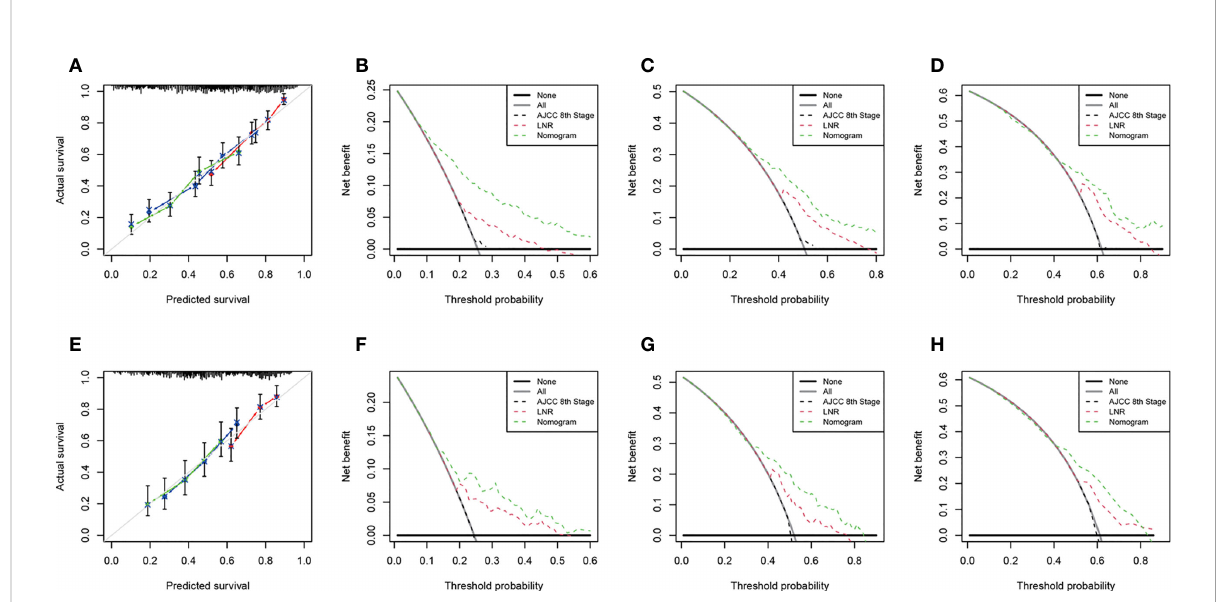
FIGURE 4 Calibration curves for OS prediction in the training cohort (A) and the validation cohort (E) . Decision curve analysis of the AJCC 8th edition staging system, nomogram and LNR for the 1- (B) , 3- (C) and 5-year (D) OS rates of PDA patients from the training cohort. Decision curve analysis of the AJCC 8th edition staging system, nomogram and LNR for the 1- (F) , 3- (G) and 5-year (H) OS rates of PDA patients from the validation cohort. OS, overall survival; LNR, lymph node ratio; PDA, primary duodenal adenocarcinoma. For calibration curves, red, blue and green lines represent 1, 3, and 5 years, respectively.